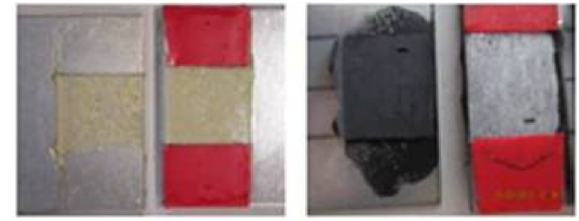
Fig. 4. Maximum shear stress of the adhesives over the temperature range